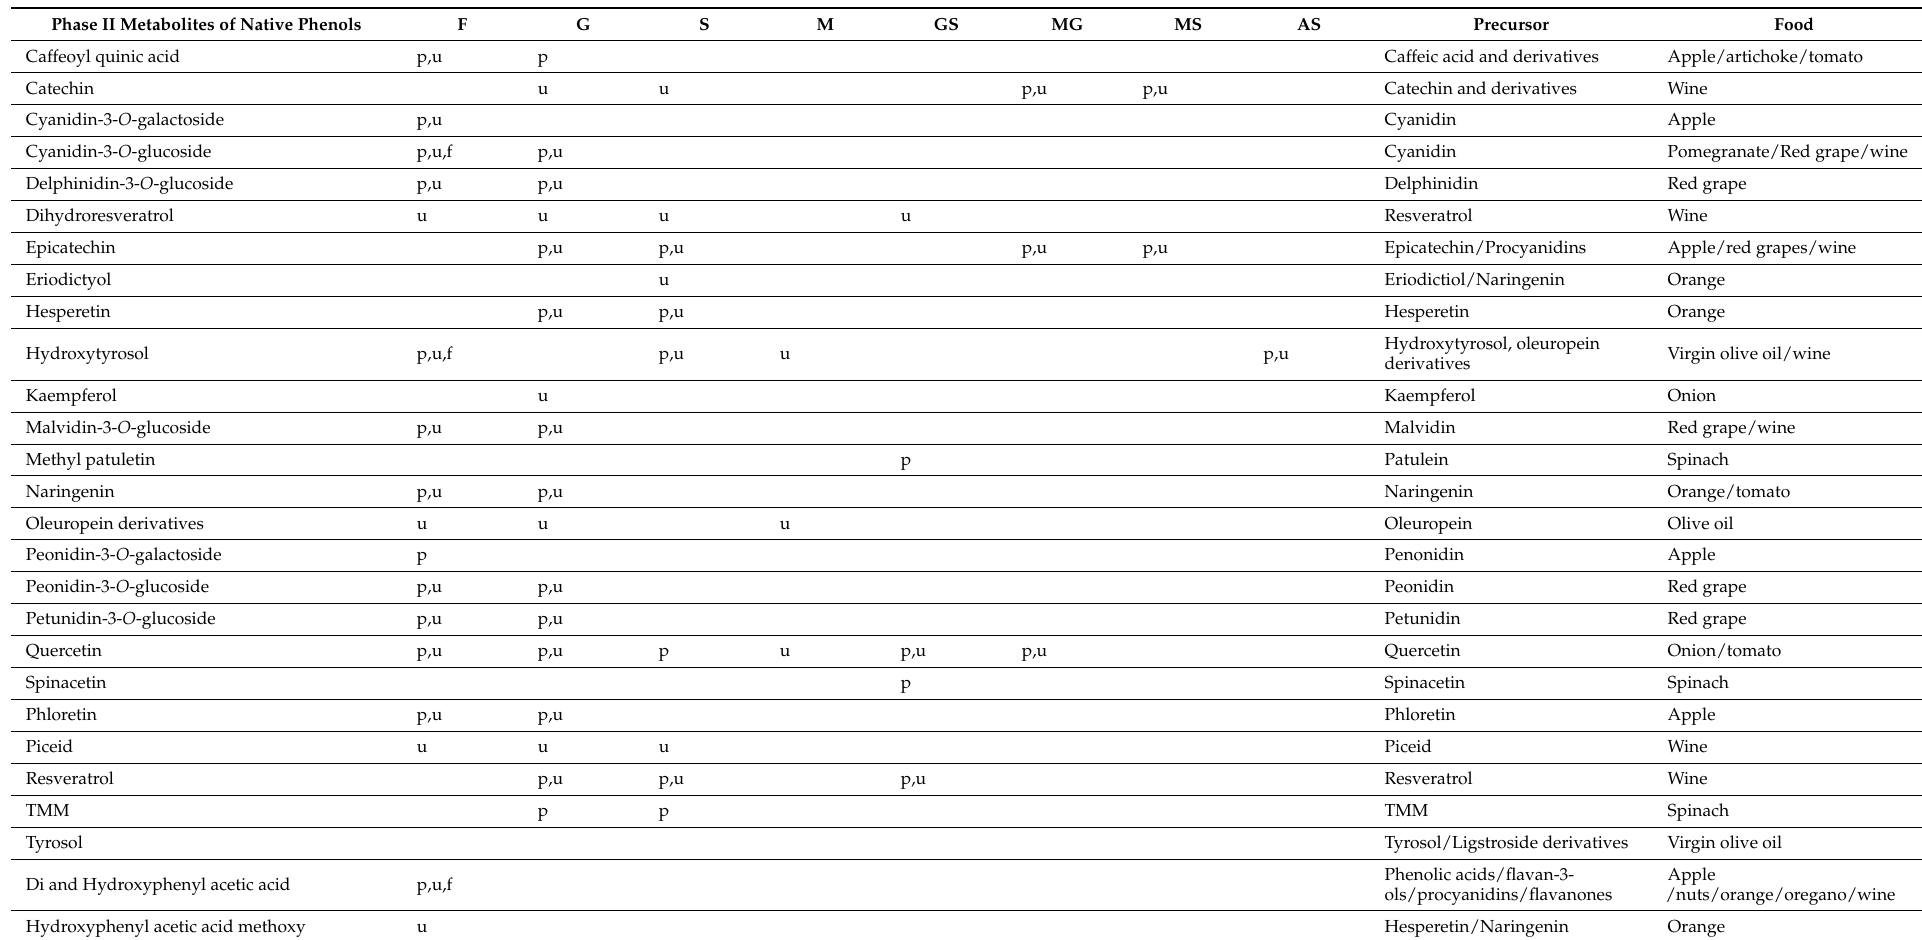
Table 7. Summary of the phenol biological metabolites proposed as a useful tool for the assessment of Mediterranean Diet